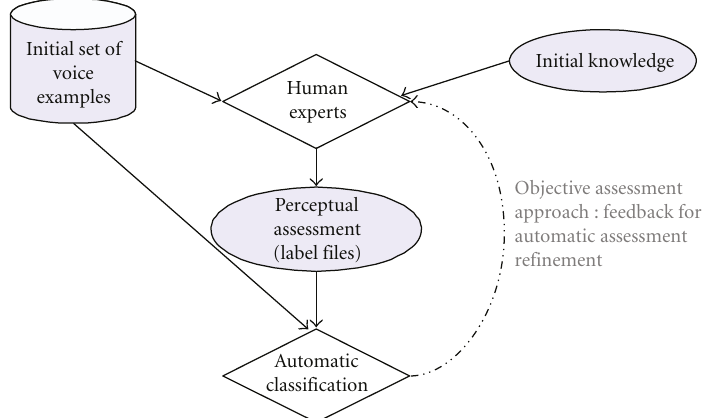
Figure 1: Objective assessment of voice quality based on an automatic classification approach and the human expertise.